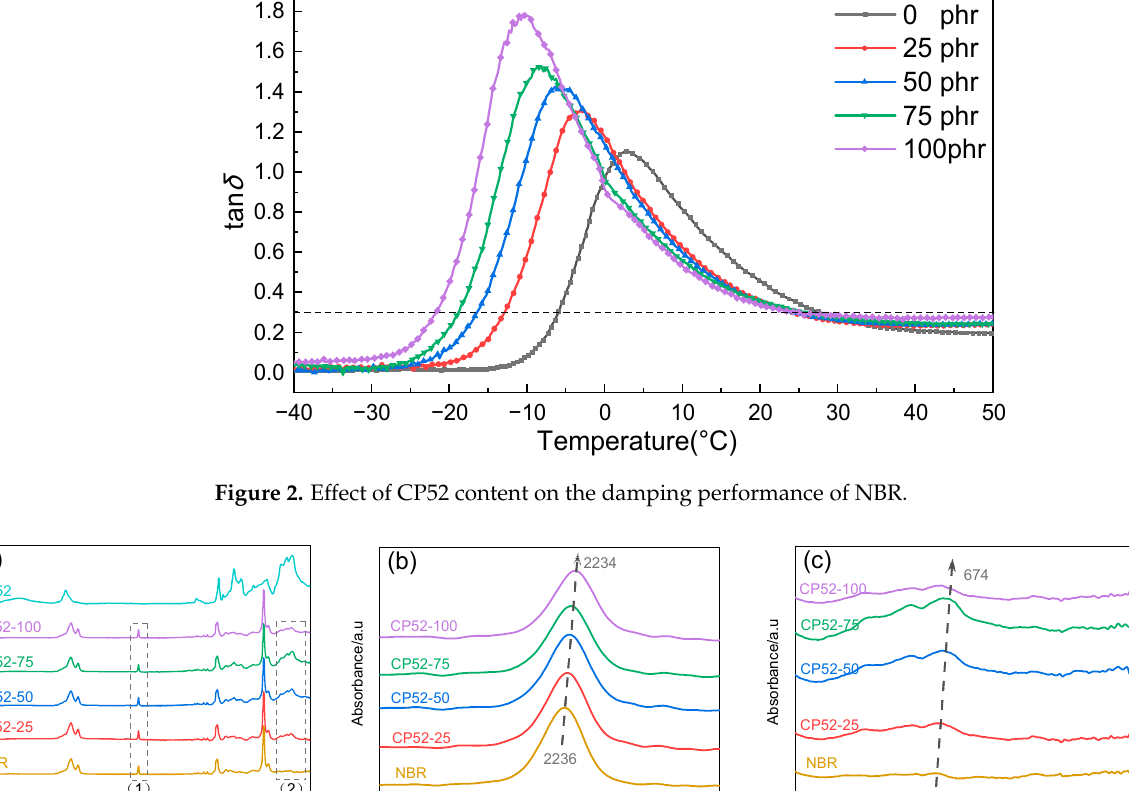
Figure 3. ( a ) FTIR spectra of CP52/NBR material ( b ) -CN ( c ) -Cl.